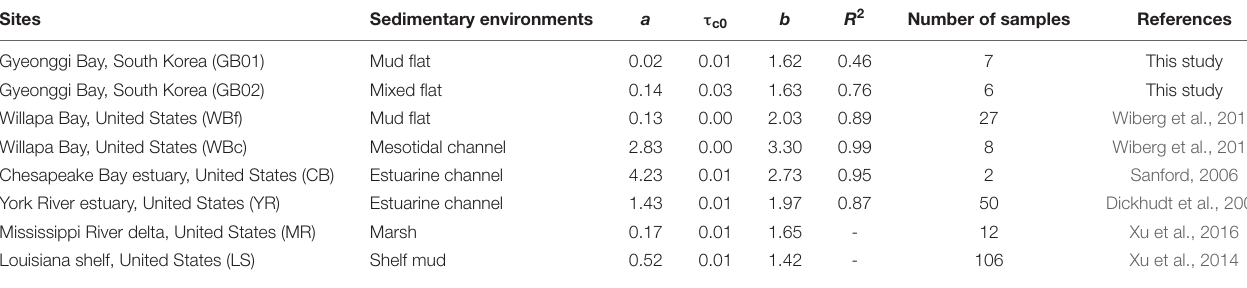
TABLE 2 | Power law fit parameters relating erosion threshold to eroded mass.